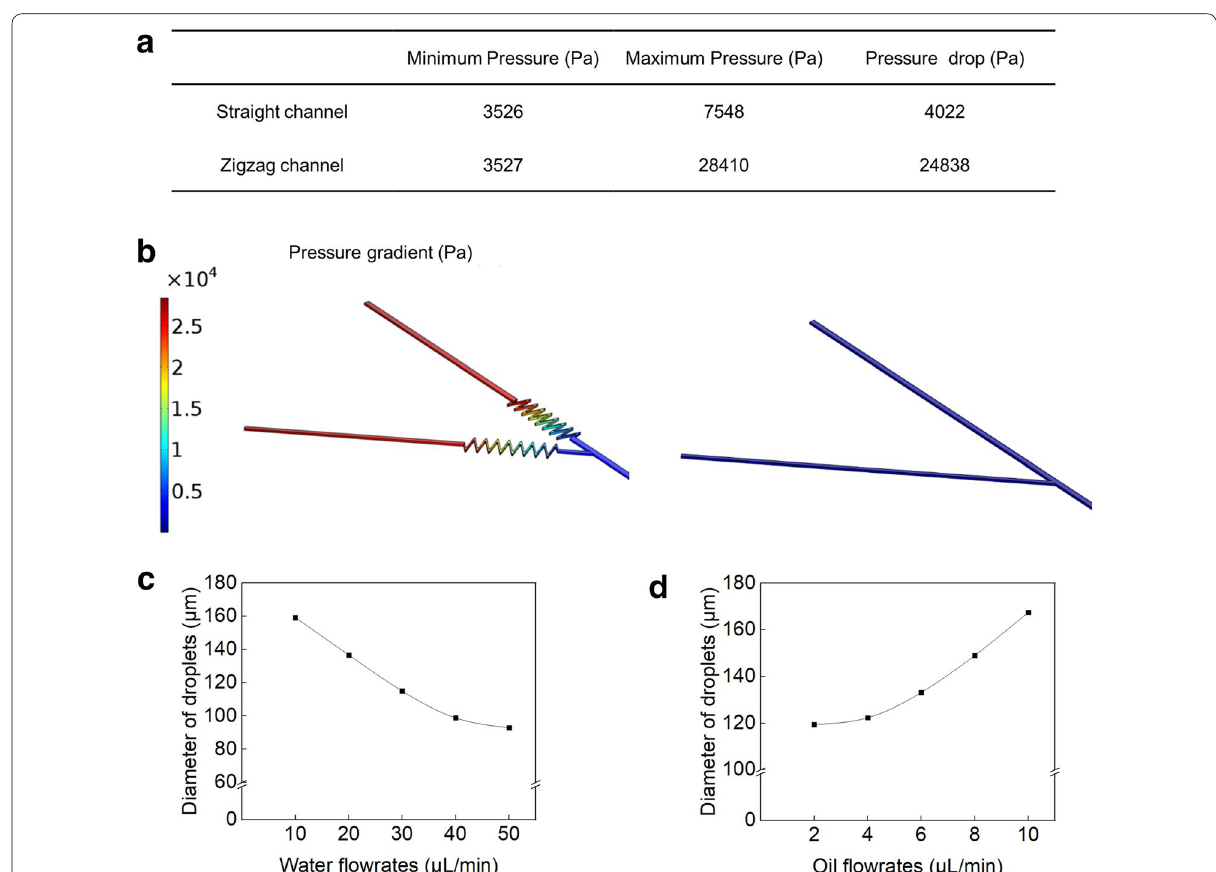
Fig. 2 CFD simulation of the first nozzle of the microfluidic device. Table comparing the pressure drop from the inlet to the first nozzle for a straight and zigzag channel ( a ). Snapshot of pressure distribution in the first nozzle for the cases in which a zigzag channel or a straight channel is used ( b ). Simulation of droplet diameter for cases in which the water flow rate ( c ), or oil flow rate ( d ) is varied and the other flowrate remains